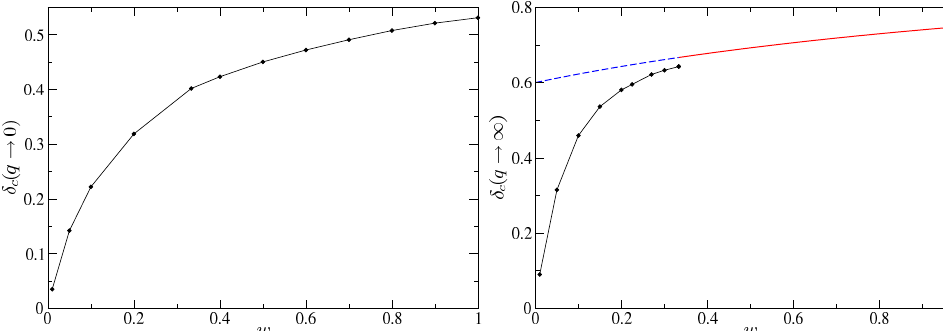
Figure 14. ( Left-panel ): Threshold δ c in terms of w for q → 0. ( Right-panel ): Threshold δ c in terms of w for q → ∞ ; in particular, we are able to perform simulation up to q = 40. The red line corresponds to the analytical case f ( w ) , where the black dots correspond to the numerical simulations in the region where δ c ( q → ∞ ) (cid:54) = f ( w ) , as shown in [84]. The blue dashed line corresponds to f ( w ) on that region.